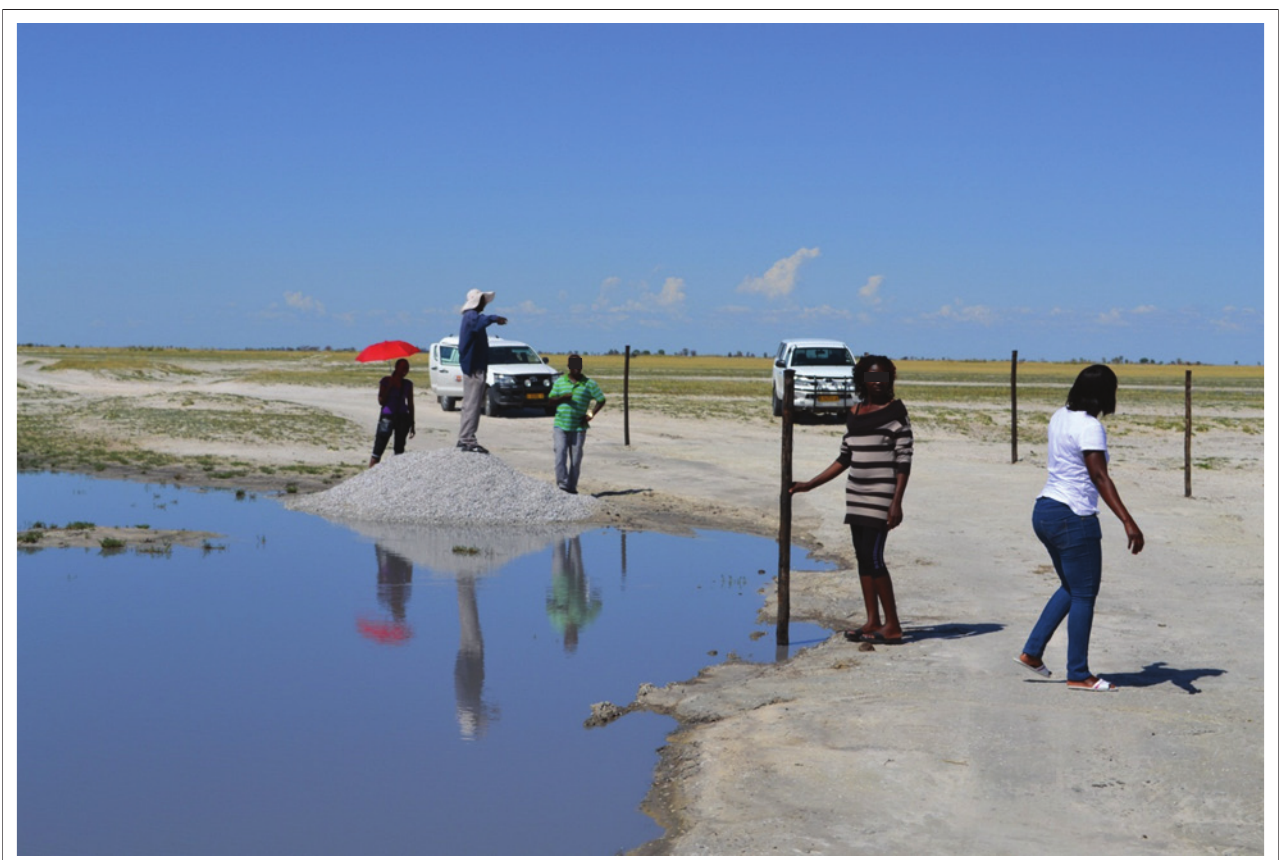
Source : Picture taken by Gert van Rooy, 2016 FIGURE 2: Picture at Ompundja village – The purpose of the poles is to indicate the water level to motorist and as guidance of the road to the drivers (traditional